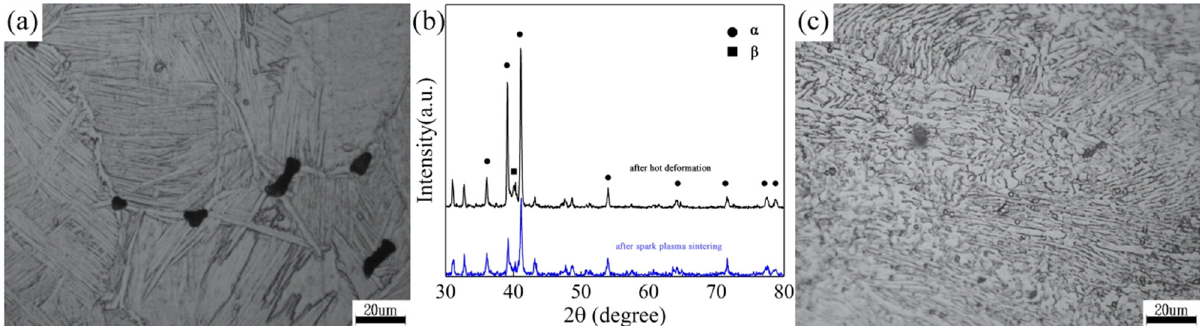
Figure 5: ( a ) OM before hot deformation; ( b ) XRD of the TC4 titanium alloy before and after the hot deformation and ( c ) OM after the hot deformation at T = 900°C at the strain rate of 0.001 s − 1